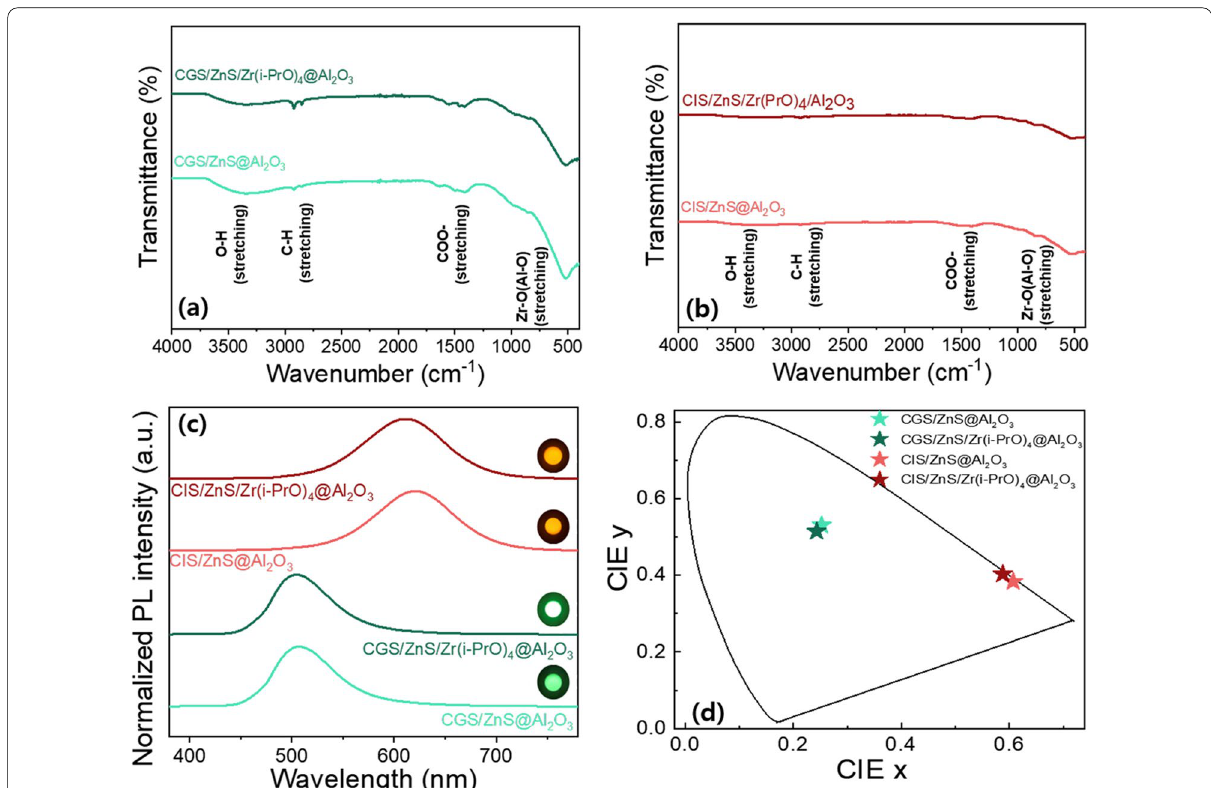
Fig. 8 FT-IR spectra of Al 2 O 3 encapsulated a CGS/ZnS based powder QDs and b CIS/ZnS based powder QDs. c PL emission spectra and photographs of emitting powder QDs (inset) and d CIE color coordinates of Al 2 O 3 encapsulated of CGS/ZnS based powder QDs and CIS/ZnS based powder